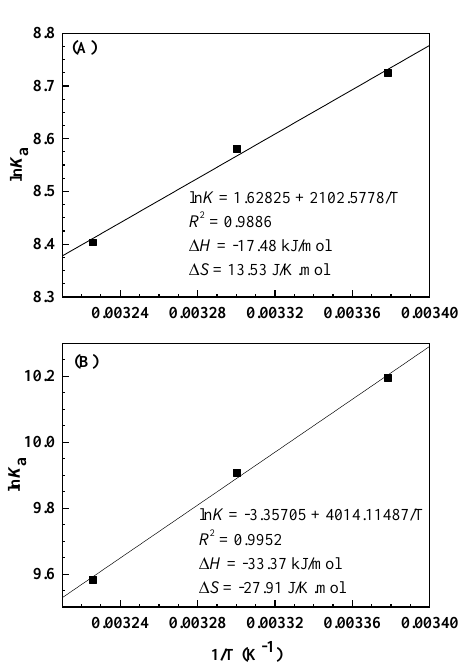
Figure 3. Van ’t Ho ff plots of the PFOA–HSA ( A ) and PFDA–HSA ( B ) systems at di ff erent Figure 3. Van ’t Hoff plots of the PFOA–HSA ( A ) and PFDA–HSA ( B ) systems at different temperatures.